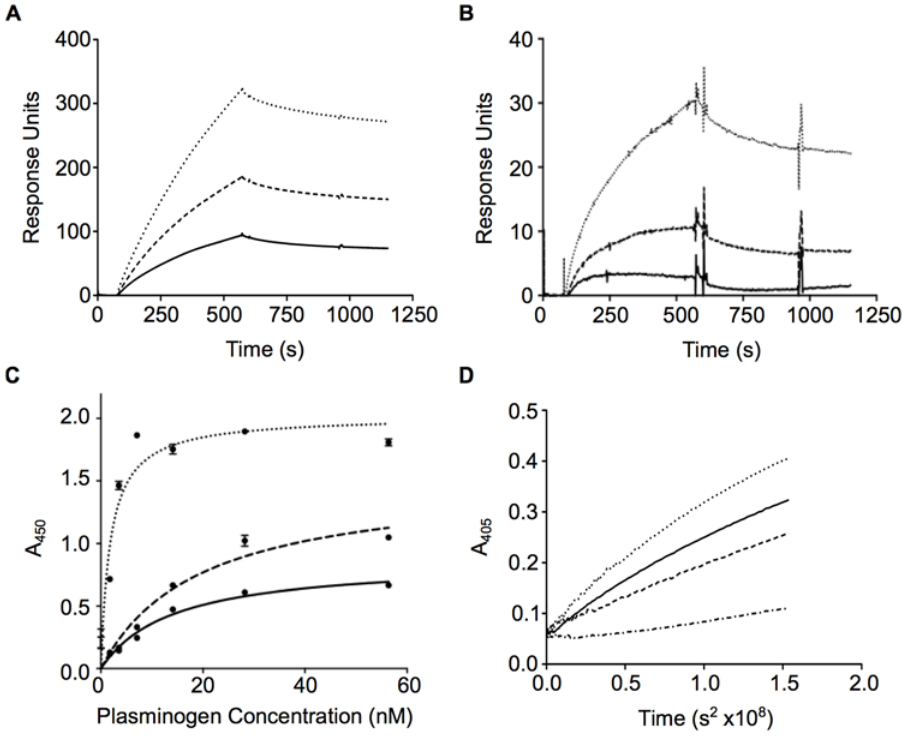
Fig 3. Plasminogen binding and activation of wild-type and mutant SEN. ( A ) Surface plasmon resonance sensorgrams for 100 nM recombinant wild-type SEN (solid), SEN K312A (dashed) and SEN K362A (dotted) binding to immobilized human Glu-plasminogen (~10,000 RUs). Binding experiments were performed in quadruplicate and the curves represent the average. ( B ) Surface plasmon resonance sensorgrams using a lower level of immobilised human Glu-plasminogen (~1,000 RUs). Analysis was carried out according to (A) and curves follow the same key. ( C ) ELISA analysis for the binding of wild-type SEN (solid), SEN K312A (dashed) and SEN K362A (dotted) (5 μ g/mL) to immobilized Glu-plasminogen. The graph shown was constructed from two independent experiments with samples in duplicate, and error bars indicate the standard deviation. ( D ) tPA activation of plasminogen in the absence (dot-dash) and presence of recombinant wild-type SEN (solid), SEN K312A (dashed) and SEN K362A (dotted) at 100 μ g/mL. Plasminogen activation experiments were performed in triplicate and the curves represent the